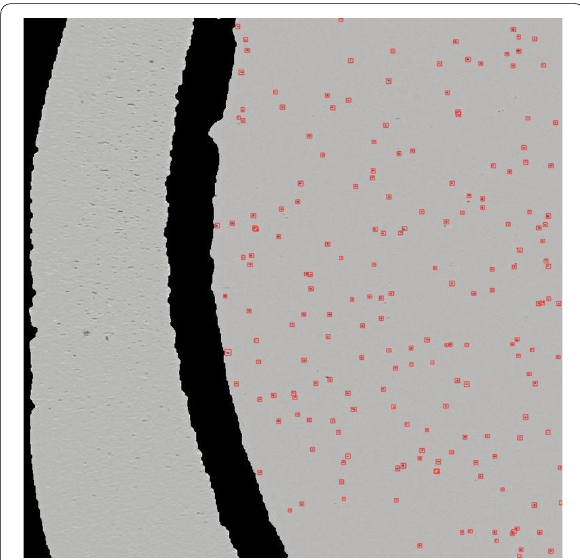
Fig. 2 Points of interest (red squares) detected by YOLOv5 in the image shown in Fig.